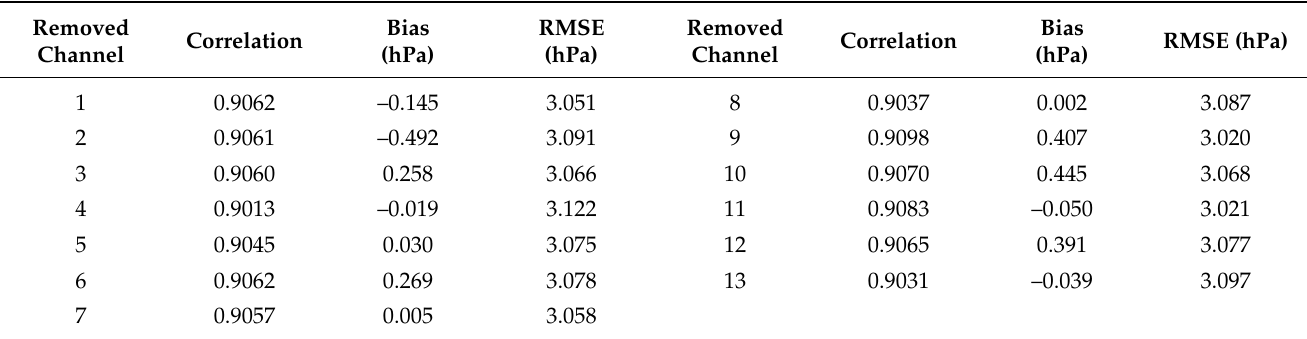
Table 4. The SSP retrieval results using the observed brightness temperatures of the partial channel